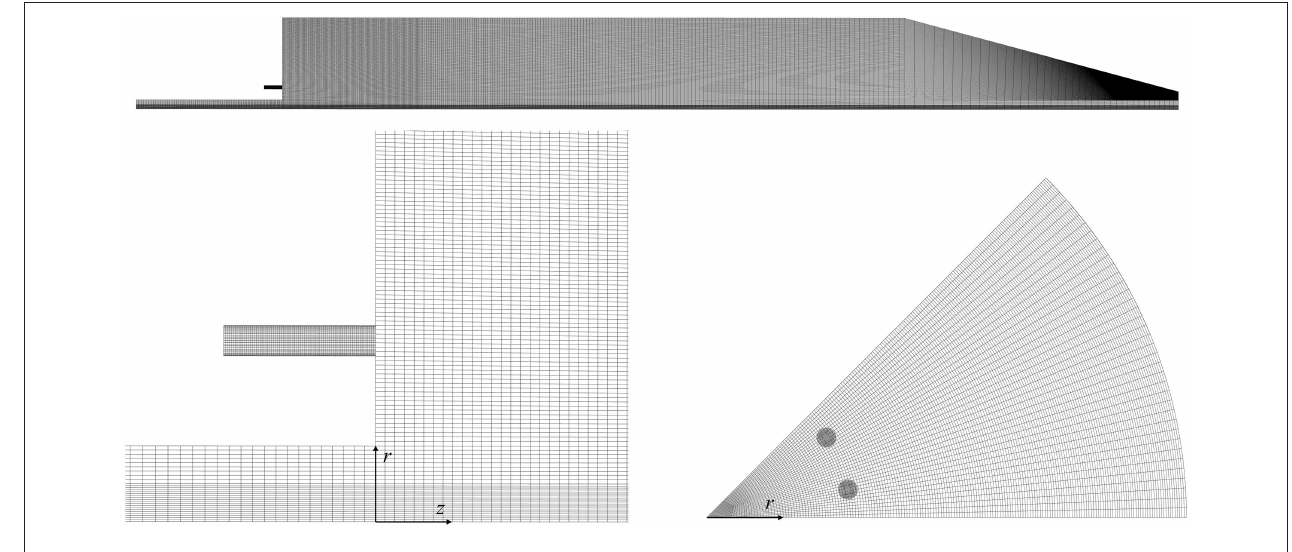
FIGURE 2 | Hexahedral mesh employed for CFD simulations.